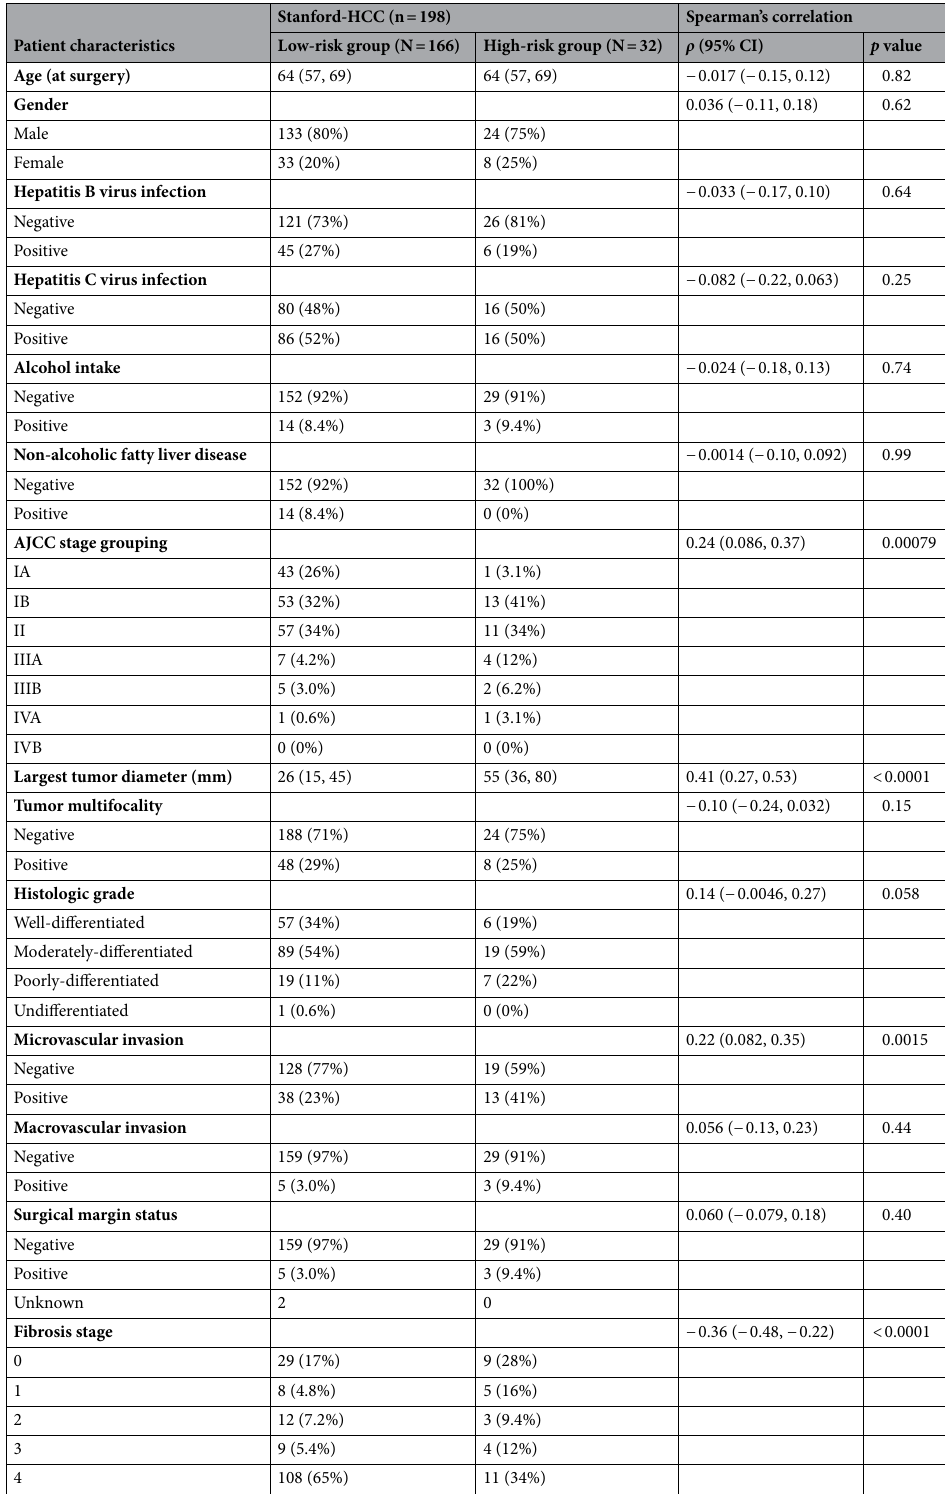
Table 4. Association between the HCC-SurvNet risk score and various patient characteristics in the external test (Stanford-HCC) cohort. Values presented: median (IQR); n